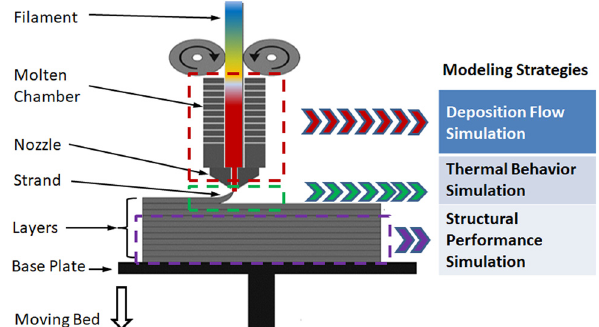
Figure 3: Schematic of simulation strategies for FDM